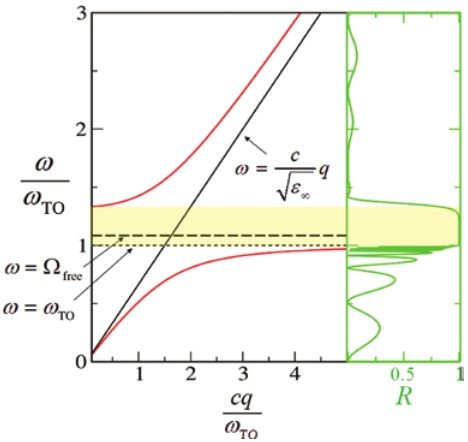
Figure 3: PhP dispersion relation. The frequency ω versus wave vector q for strongly coupled lattice optical phonons (long-dashed horizontal line at Ω ) with the free radiation field (slanted solid lines) signifying mixed phonon-photon modes (red lines). The asymptote at the lower branch (short-dashed horizontal line) designates the frequency of the TO phonon, ω . The TO yellow shaded regions represents the PhP gap or reststrahlen band (region of no mixed phonon-photon modes). Conversely, a slab of material in this frequency region is nearly perfectly reflecting. [See reflectance, R (green line).] ε and c represent the high frequency ∞ permittivity of the material and speed of light,